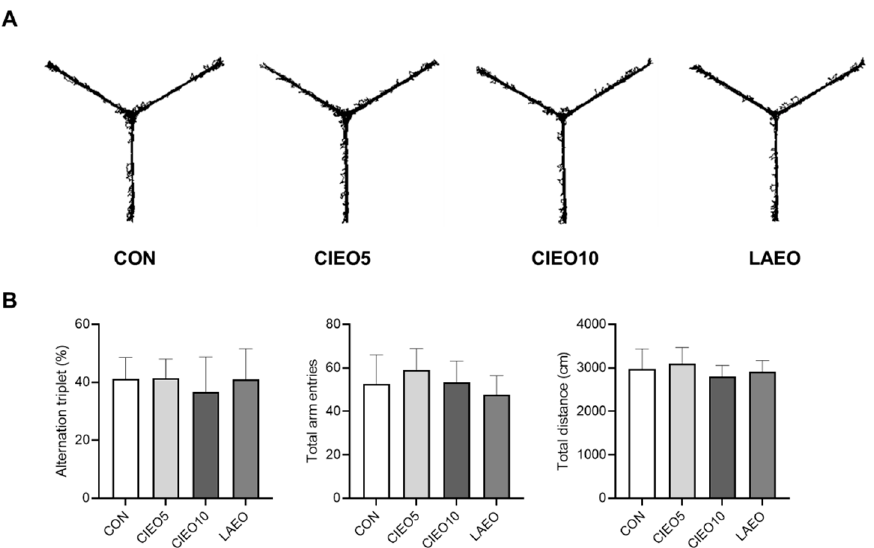
Figure 5. Effect of CIEO on working memory in mice. ( A ) Representative traveling paths in the Y maze test. ( B ) The alternation triplet, total arm entries, and total distance were recorded in a 10-min session. Data represent means ± SDs ( n = 8 per group). CON: control; CIEO: cinnamon essential oil; LAEO: lavender essential oil.